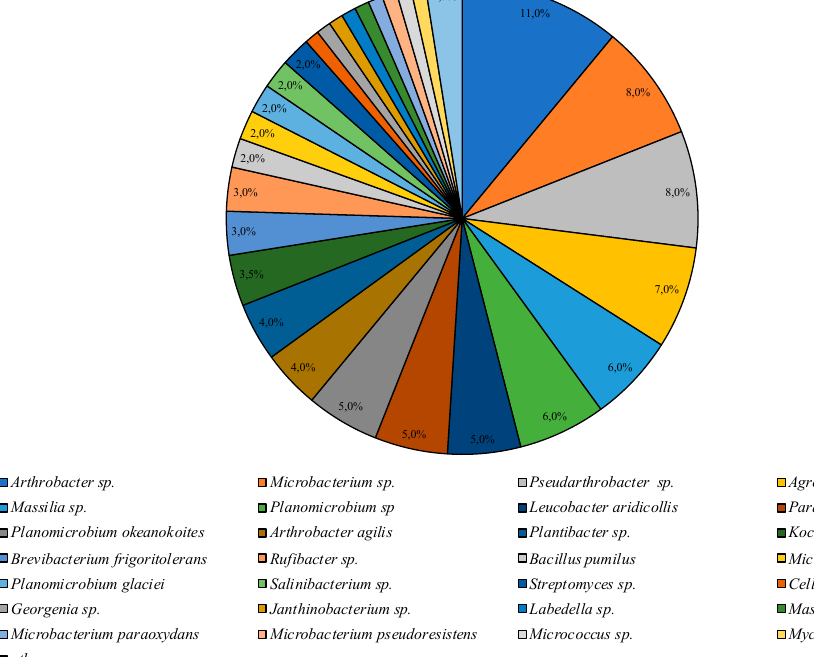
Figure 3. Structure of the culturable bacterial community isolated on PYG medium at 25 °C. Hidden percentage corresponds to 1%; the “others” group includes Bacillus sp., Brachybacterium sp., Massilia varians , Microbacterium aurantiacum , and Pseudarthrobacter oxydans represented by 0.5% each.